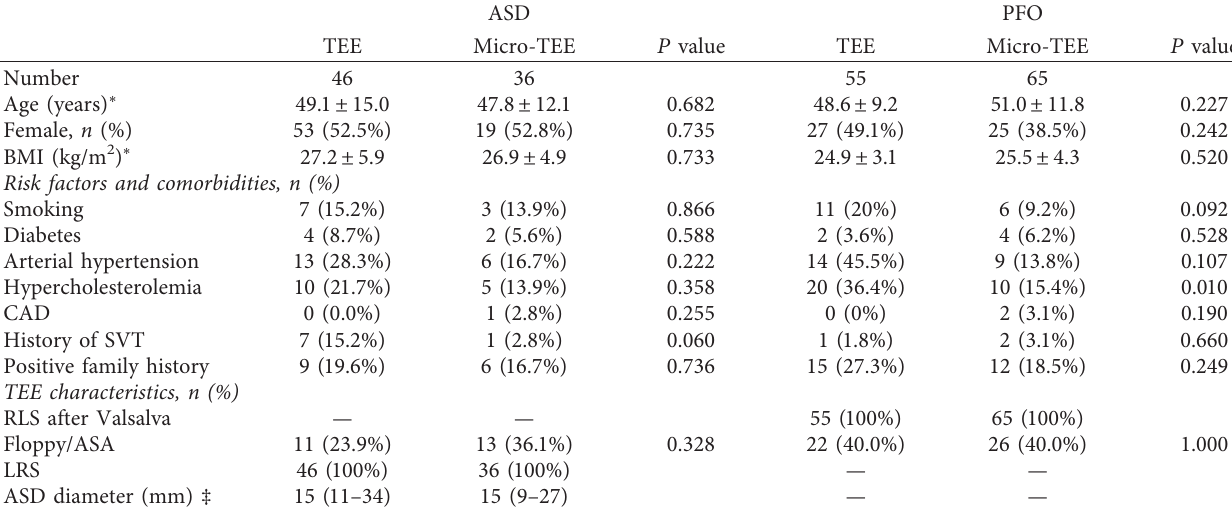
Table 1: Baseline